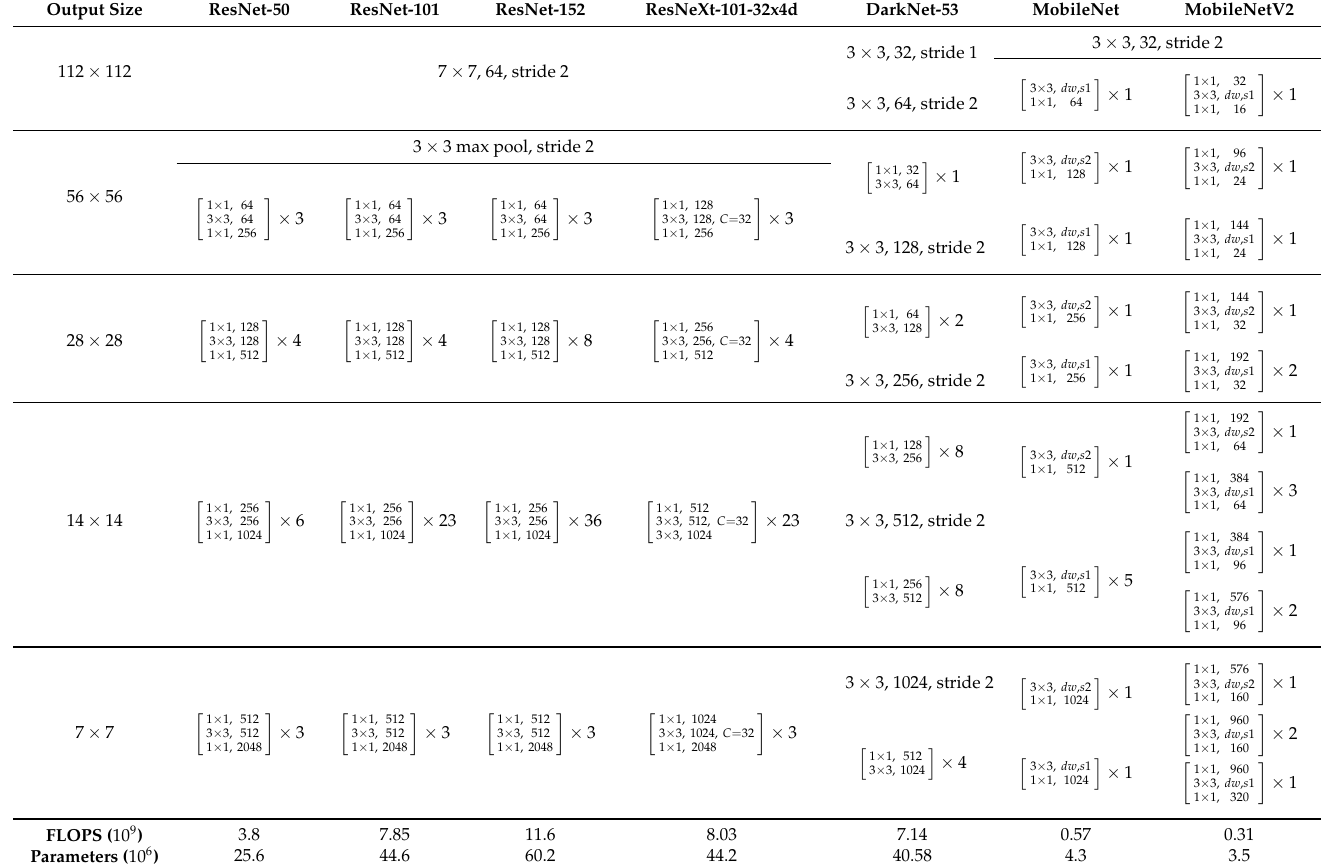
Table 3. Architectures of the different feature extractors used in the study. The output size is computed for a 224 × 224 input image. Building blocks are shown in brackets. For ResNet, downsampling is performed in the first operation of each residual block using stride 2. For ResNeXt, C = 32 indicates grouped convolutions with 32 groups. For MobileNet, the stride is indicated with s 1 and s 2, and depth-wise convolutions are noted with dw